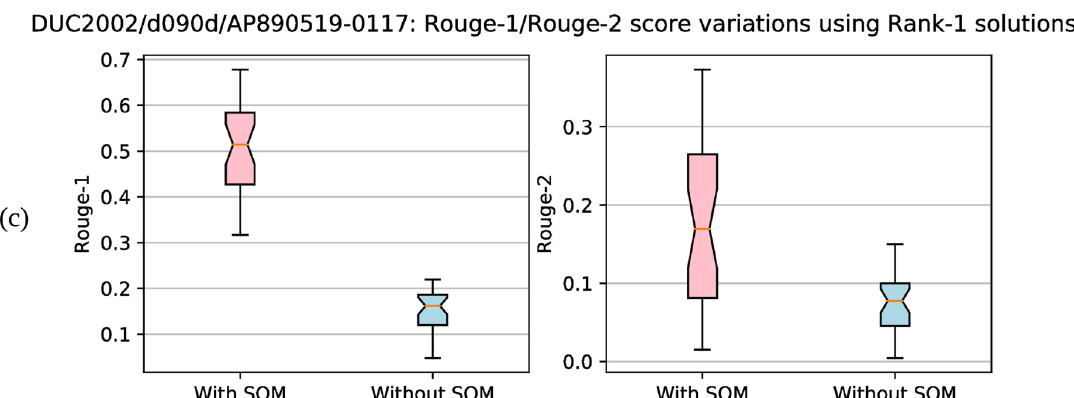
Fig 9. Box plots. Sub-figures (a), (b) and (c) show the Rouge-1/Rouge-2 score variations per document over DUC2002 dataset. In each colored box, the horizontal colored line indicates the median value of Rouge-1/Rouge-2 score using rank-1 solutions of a